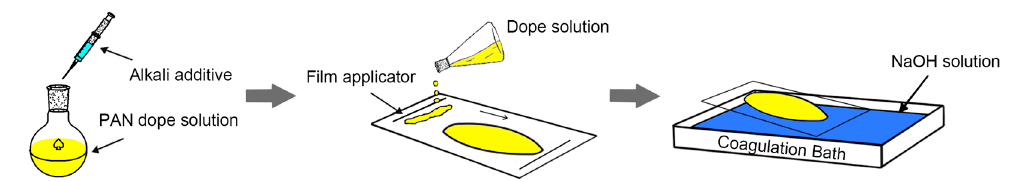
Figure 2. Procedures for preparing the pre-hydrolyzed PAN-based membrane.